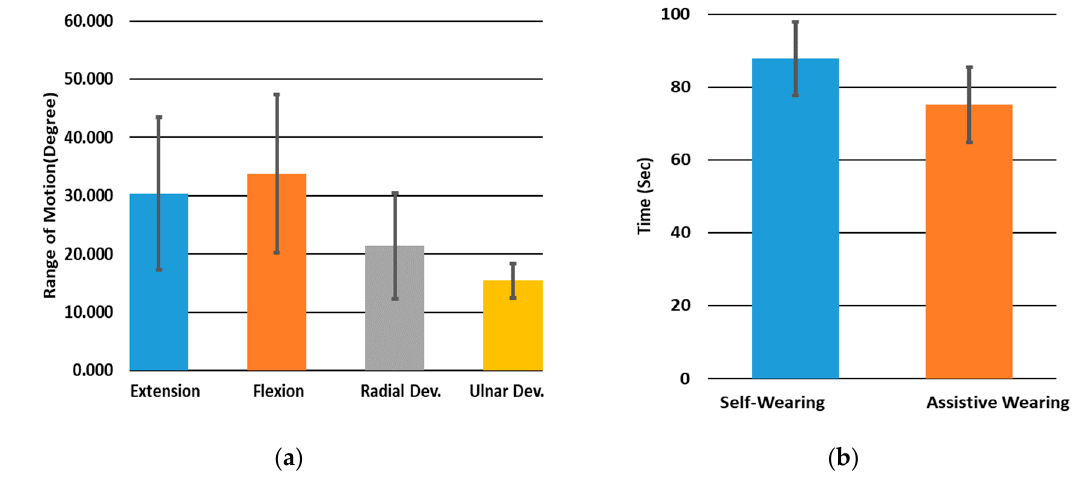
Figure 10. User test of the proposed robot for five subjects, ( a ) range of motion, ( b ) wearing time.